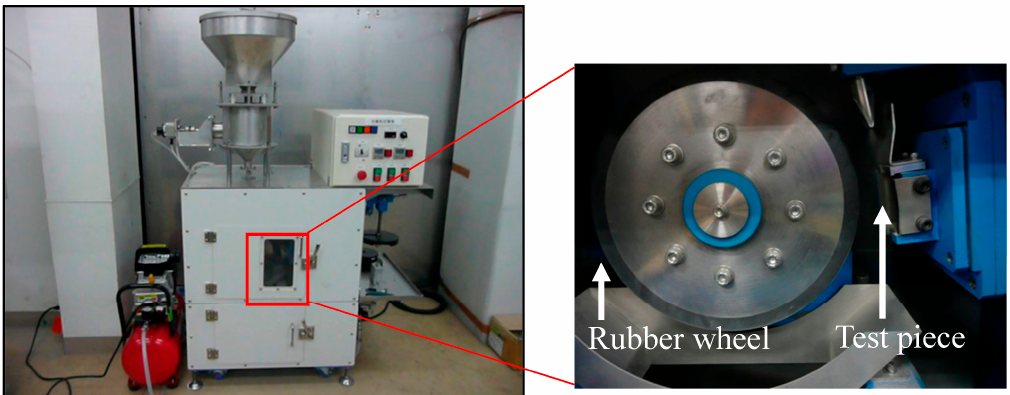
Figure 2. A rubber wheel three-body abrasive wear machine test according to the ASTM G65 standard.